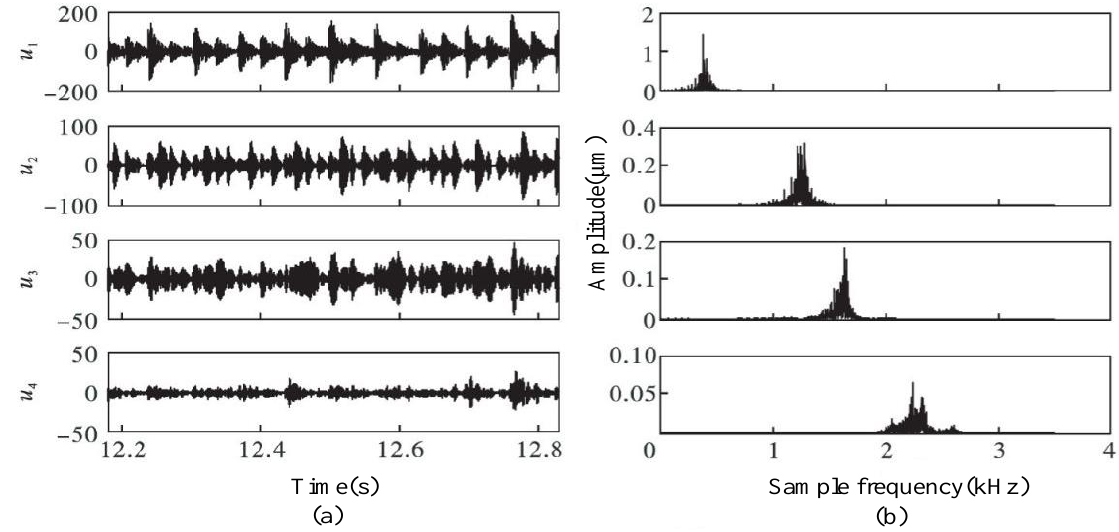
Figure 5. Result of VMD processing. ( a ) IMFs. ( b ) Spectrogram.